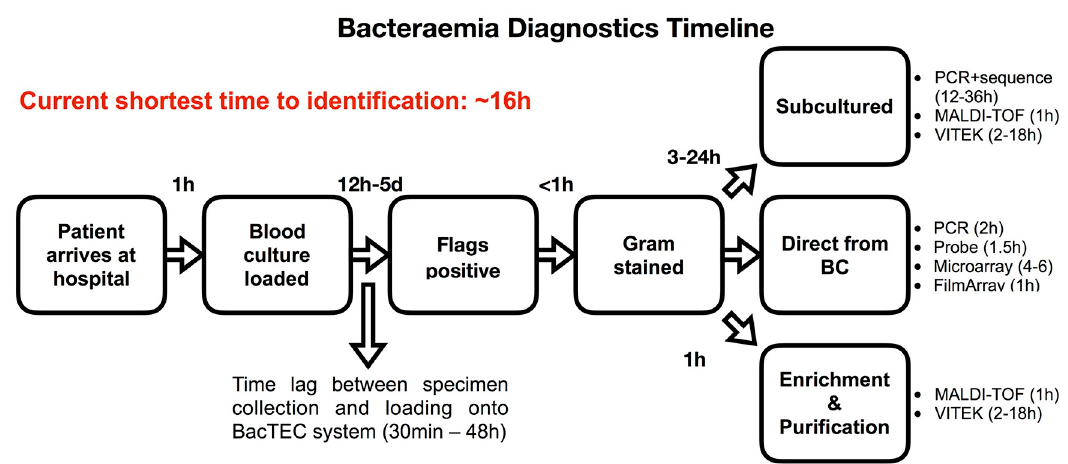
Fig 1. Timeline of current bacteraemia diagnostics. Diagram showing major stages in current bacteraemia diagnostics featuring three main test streams with a minimum of 16 hours and maximum of 2 or more days for definitive bacterial identification.